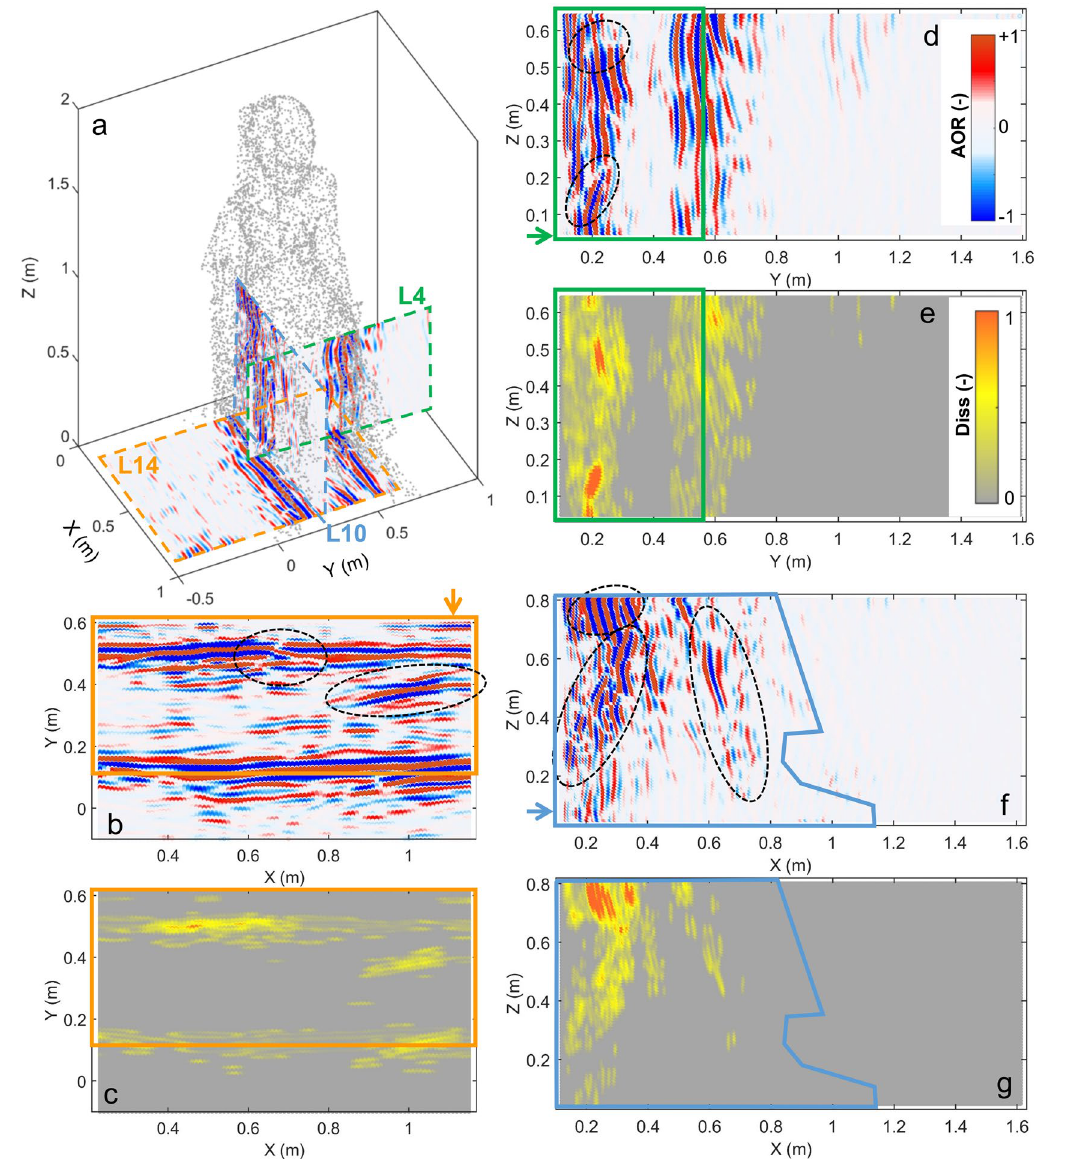
Figure 3. ( a ) Subsampled 3D point cloud of the statue with a selection of three orthogonal radar scans acquired in longitudinal polarization (L4, L10 and L14). ( b – c ) Scan L14: ( b ) processed radargram, ( c ) local dissimilarity. ( d – e ) Scan L4: ( d ) processed radargram, ( e ) local dissimilarity. ( f – g ) Scan L10: ( f ) processed radargram, ( g ) local dissimilarity. In ( b ) to ( g ) the GPR results inside the statue are bordered by colored polygons. The arrows indicate the side on which the GPR antenna was located during the acquisition. Figure created in Matlab (version R2021b, https:// it. mathw orks. com/ produ cts/ matlab. radargram (T11, Fig. 4d). The bottom of the throne is found to be quite transparent to the EM signal penetra- tion in both polarizations (Fig. 4b,e). On the top of the statue (at Z > 0.8 m), the strongest reflections can be referred to the visible elements or edges of the statue, at the transition between the stone material and the outside. In particular, the throne edges and other point-like elements, such as the arms, right hand and head originate marked reflections in the radargrams, with 3D superimposition of the effects. Despite these geometric effects, the amplitude of the reflection is not found to be homogeneous within the statue. Anomalous reflection patterns are observable in the upper part of the throne, above the hips and in the face of Ramses II. They are also particularly widespread in the back support of the statue, close to the head of the statue (Fig. 4b,e). The local dissimilarity anomalies of the two polarizations show consistent locations and clearly highlight the most fractured areas (Fig. 4c,f).